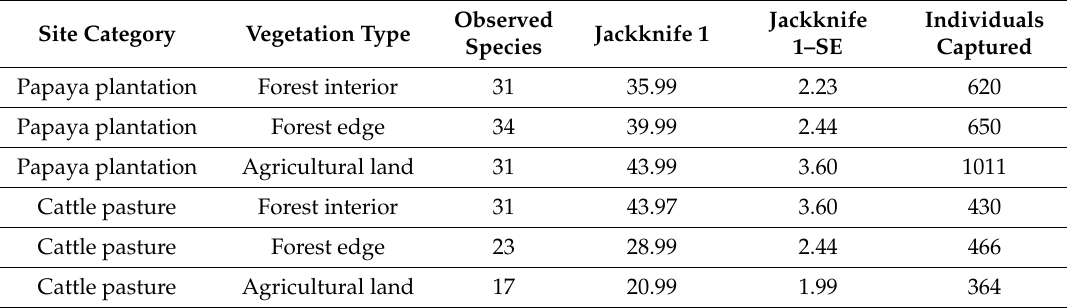
Table 3. Overall observed and estimated species richness for di ff erent vegetation types per site category. SE = standard error.